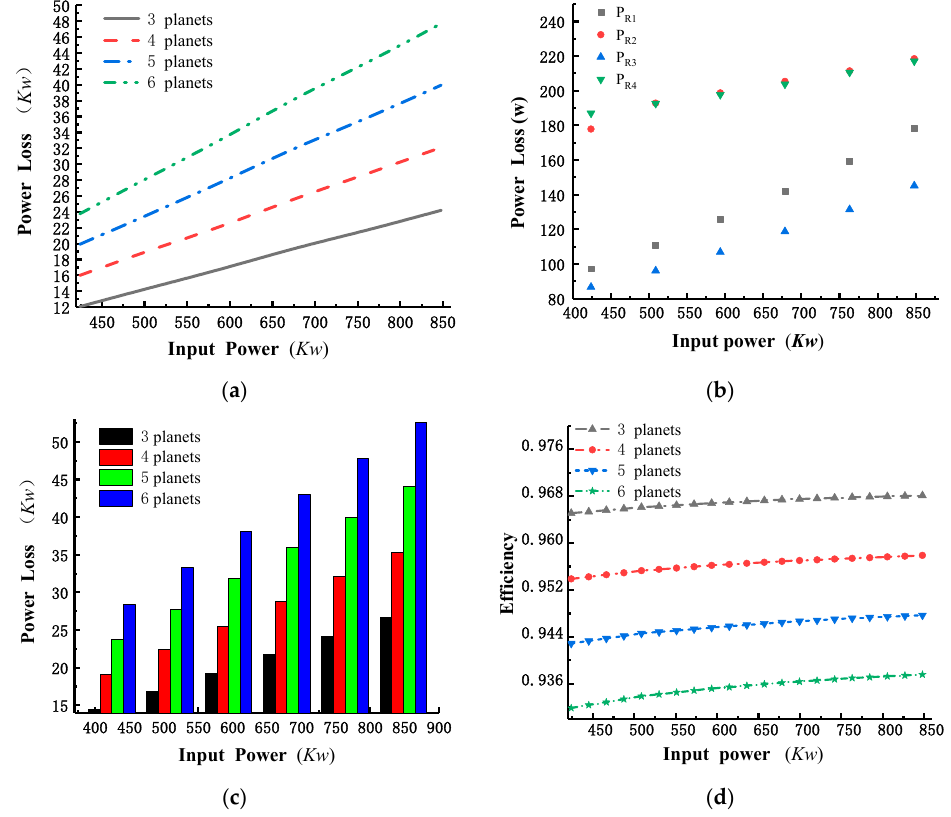
Figure 18. Variation of power loss and transmission efficiency with input power. ( a ) Gear tooth frictional power loss; ( b ) bearing power loss; ( c ) total power loss; ( d ) total transmission efficiency.